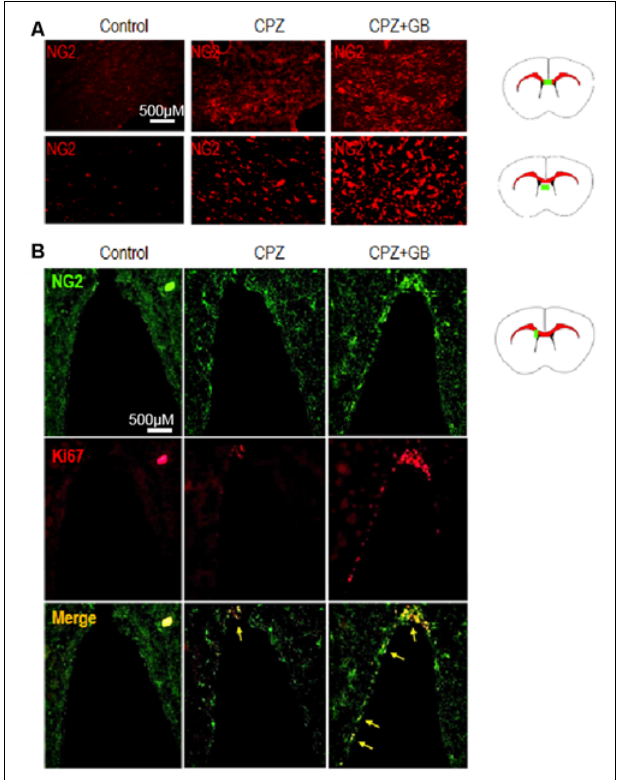
FIGURE 9 | GB promoted the generation of NG2 oligodendrocyte precursor cells (OPCs). Mice were fed with chow containing 0.2% CPZ for 6 weeks and were intraperitoneally injected with GB for 14 consecutive days from the 4th to 6th week of CPZ feeding. (A) NG2 + OPCs in the corpus callosum and lateral septal nucleus of the brain by immunohistochemistry, and (B) double immunohistochemical staining with anti-NG2 and anti-Ki67 in the subventricular zone (SVZ; yellow arrow) by immunohistochemistry. Representative images are obtained from three to four mice/each group, with similar